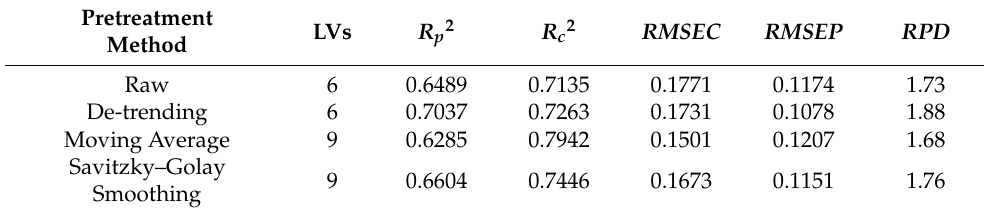
Table 2. Prediction results of PLSR with different preprocessing